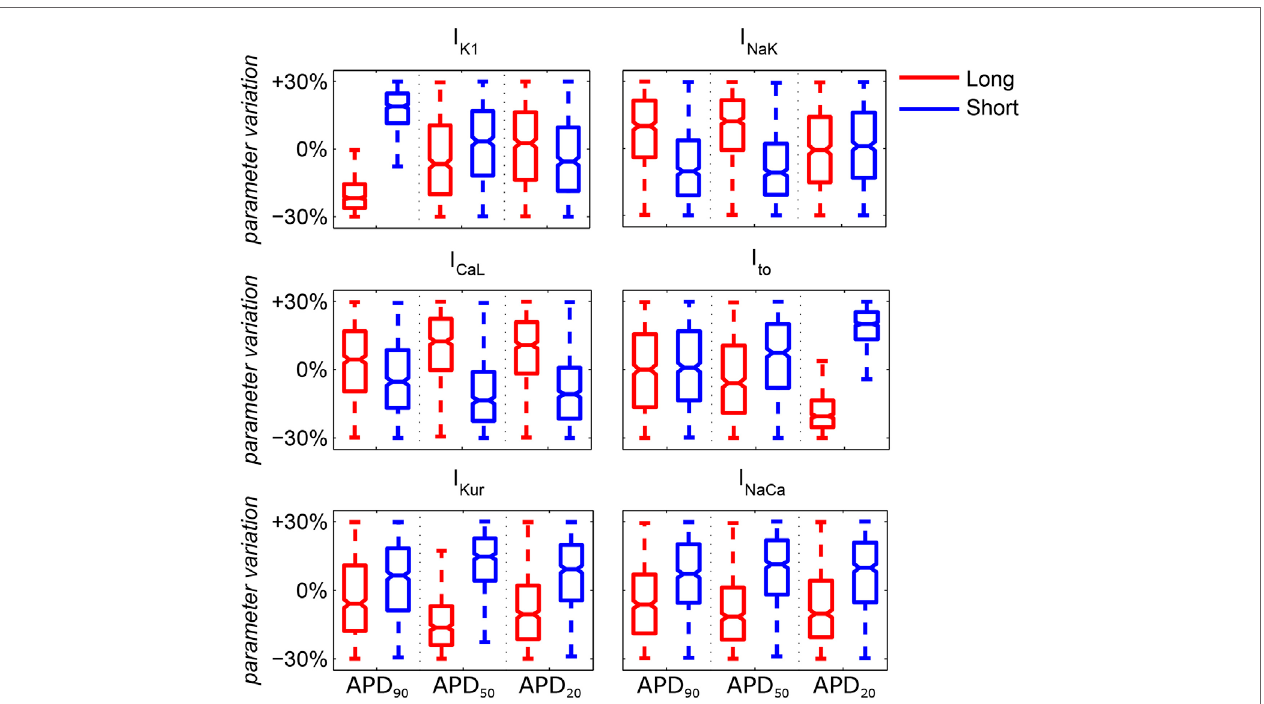
FigUre 2 | Median values and ranges of variability in ionic conductances in the six subpopulations of human atrial action potential models under atrial fibrillation remodeling . Blue and red indicates short and long APD 90 , APD 50 , and APD 20 , respectively. Each boxplot represents the range covered by the ionic conductances: the edges of the box are the first and third quartiles, whiskers extend to the most extreme data points, the estimated median physiological value is the central horizontal line and the notch around the median is the 5% significance